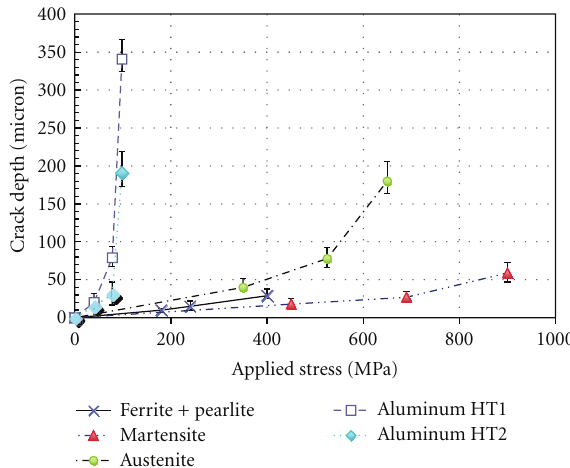
Figure 4: Crack depth as a function of applied stress.